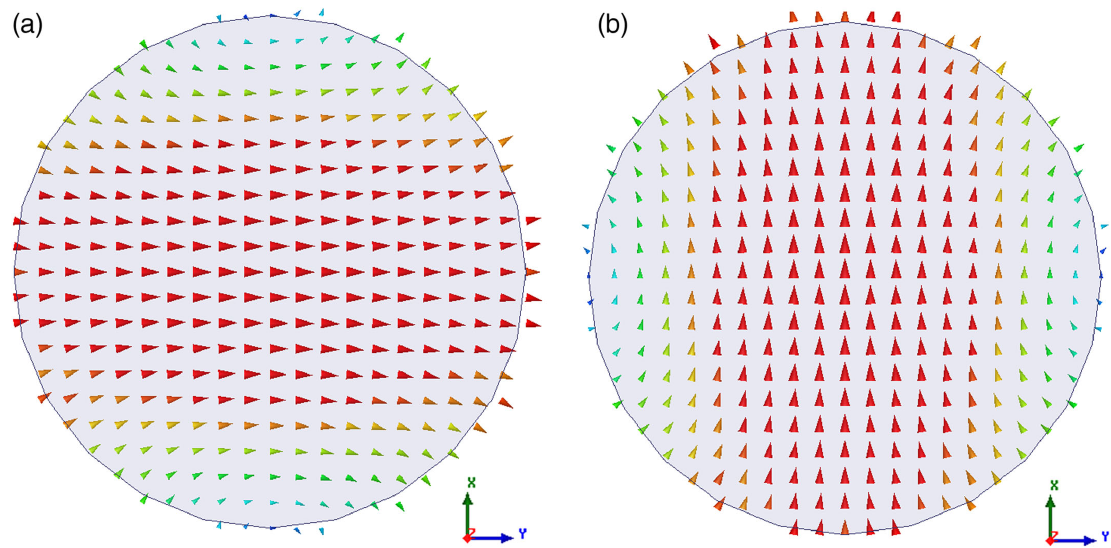
FIG. 2. Electric field pattern on TE11 modes in a circular waveguide with different polarizations. A: TE11 mode in horizontal polarization; B: TE11 mode in vertical